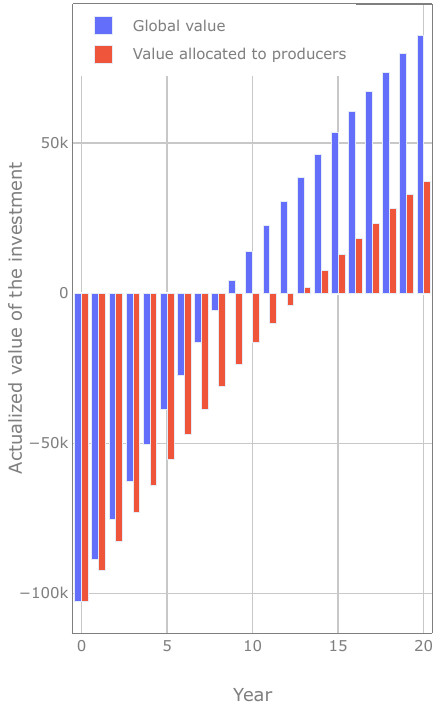
Figure 12. Investment cash flows obtained by the producers applying redistribution rules.